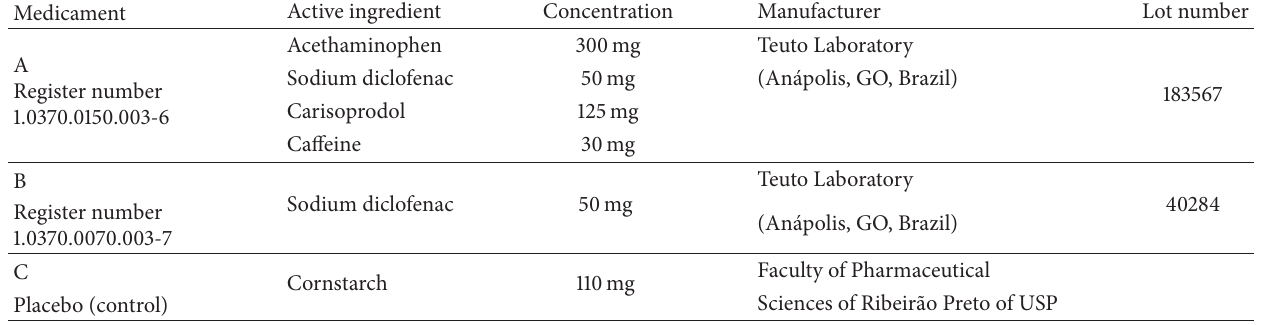
Table 1: Composition, active ingredients, concentration, manufacturer, and lot number of drugs used in the study.